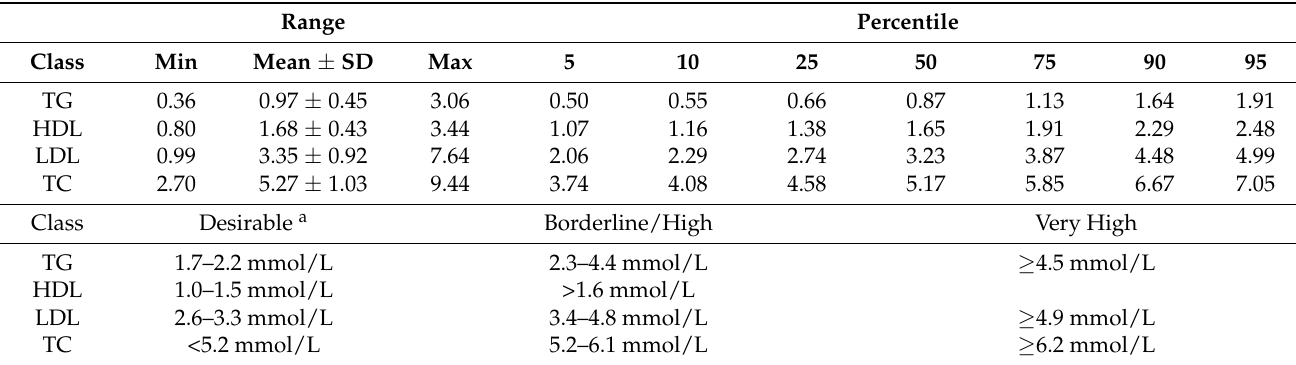
Table 4. Reference ranges and clinical cut-offs of lipid